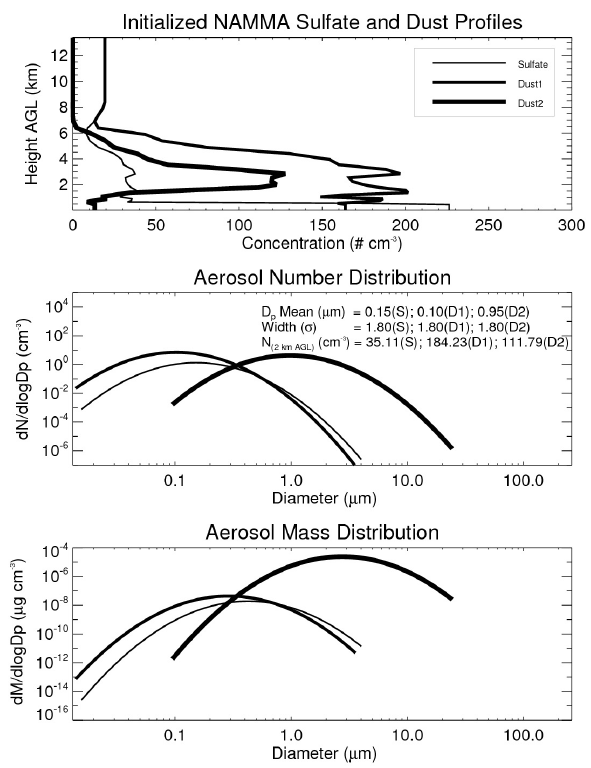
Fig. 2. Aerosol data from NASA African Monsoon Multidisci- plinary Analyses (NAMMA) in 2006. The three aerosol species rep- resented in the study are sulfate (thin), small dust (medium thick- ness), and large dust (thick). Top: the initialized horizontally ho- mogeneous profiles (cm − 3 ) ; middle: aerosol number distribution at 2kma.g.l.; and bottom: aerosol mass distribution at 2kma.g.l. Also shown in (middle) are the geometric mean particle diameter, dis- tribution width parameter, and the total number concentration for sulfate (S), Dust1 (D1), and Dust2